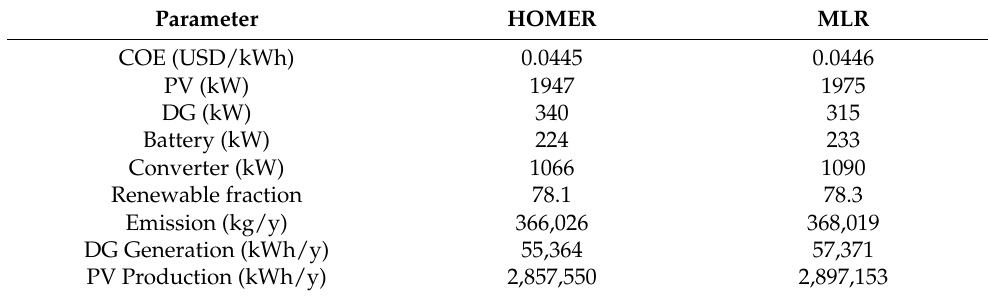
Table 10. Comparison between HOMER Pro and MLR for the configuration of PV/Battery/DG.